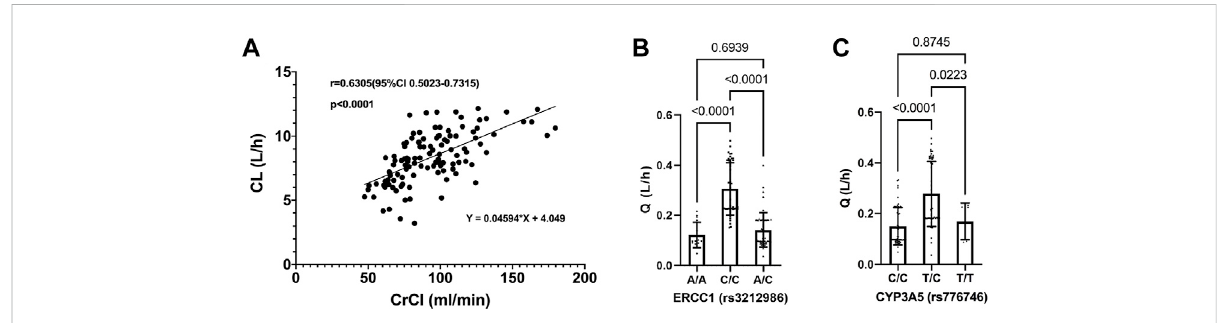
FIGURE 2 Relationshipbetweenpemetrexedclearanceandcovariates. (A) Pemetrexedclearancevs.CrCl,aspearmancorrelationanalysisisusedto fi tthe scatter plot; (B) Pemetrexed intercompartment clearance vs. ERCC1 (rs3212986); (C) Pemetrexed intercompartment clearance vs. CYP3A5 (rs776746); Statistical difference is analyzed by one-way